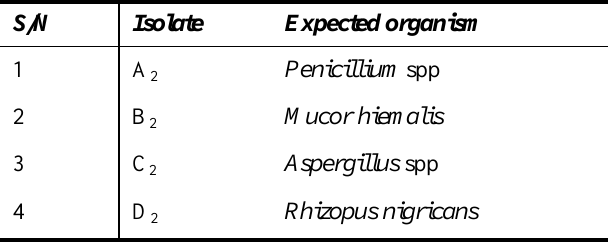
Table 7. Fungal isolation and identification of roasted and fried meats (beef and chickens).